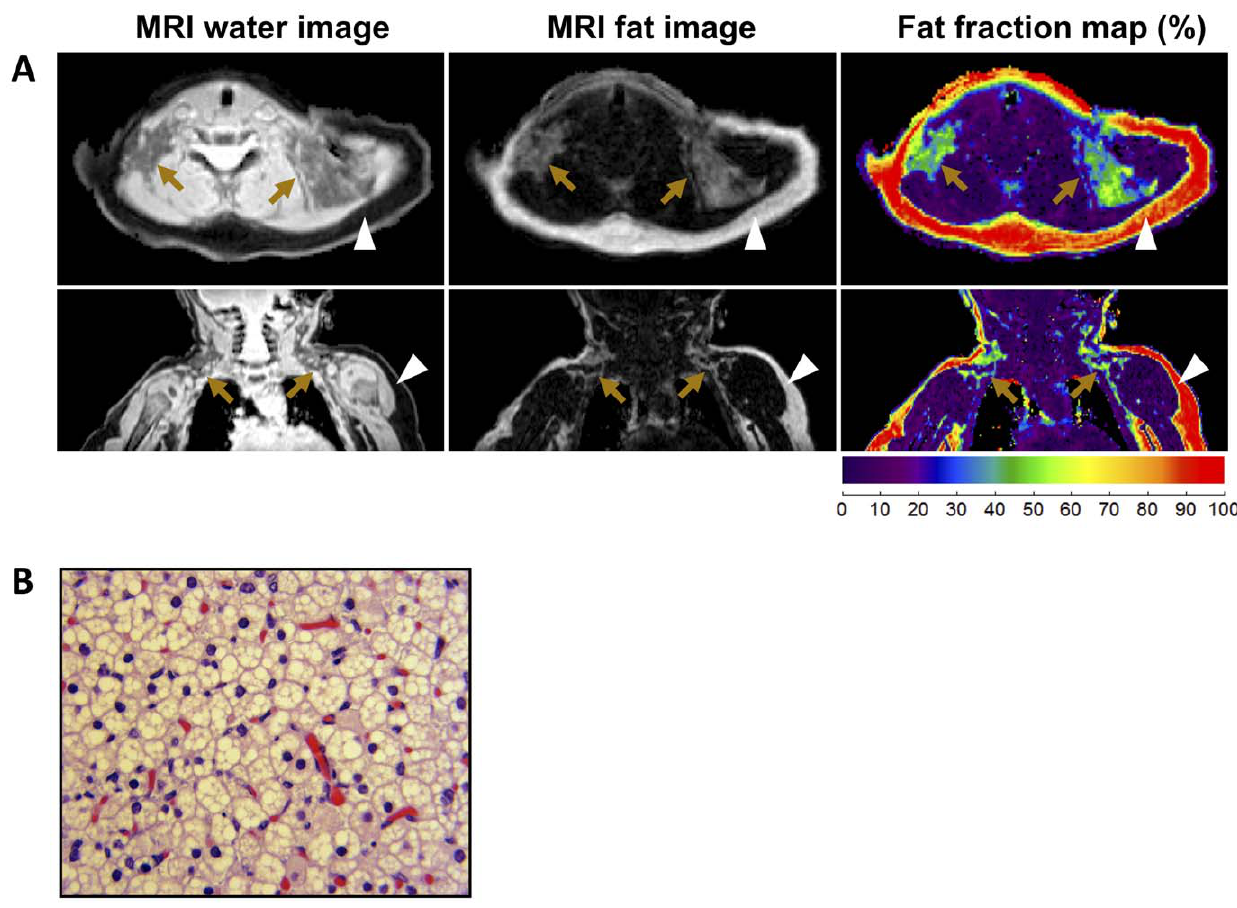
Figure 2. Isolation of human BAT from multiple BAT depots. ( A ) Axial (top) and coronal (bottom) MRI scanning images illustrating bilateral supraclavicular BAT depots from chemical-shift water-fat MRI in a 4-months-old female. BAT depots are denoted by arrows and subcutaneous WAT depots are denoted by arrowheads. The first column shows the water images. The second column shows the fat images. The third column shows the fat fraction map of water content, which translates to a lower fat fraction in BAT than WAT. The coronal images were obtained anteriorly at the level of the humeral epiphysis. ( B ) The isolated BAT depots were fixed and stained by H&E. The sample was obtained from the left supraclavicular area of the same 4-month old female shown in the MR images in Fig. 2A. Note that nearly all the isolated BAT samples consisted of brown adipocytes containing multilocular lipid droplets.